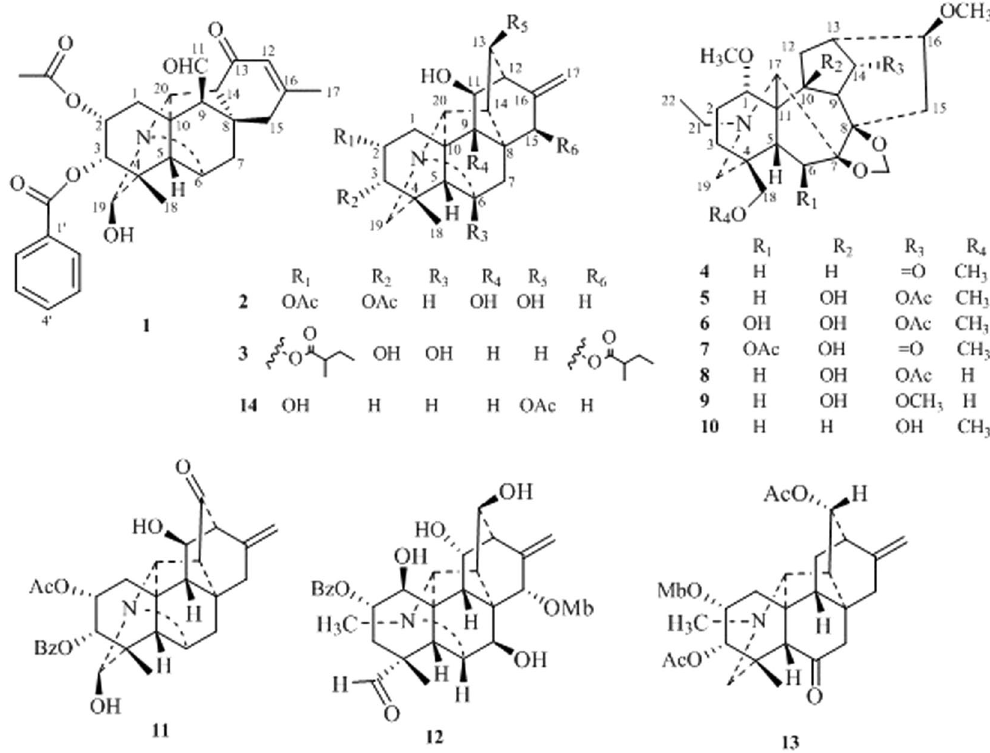
Figure 1. Structures of compounds 1 – 14